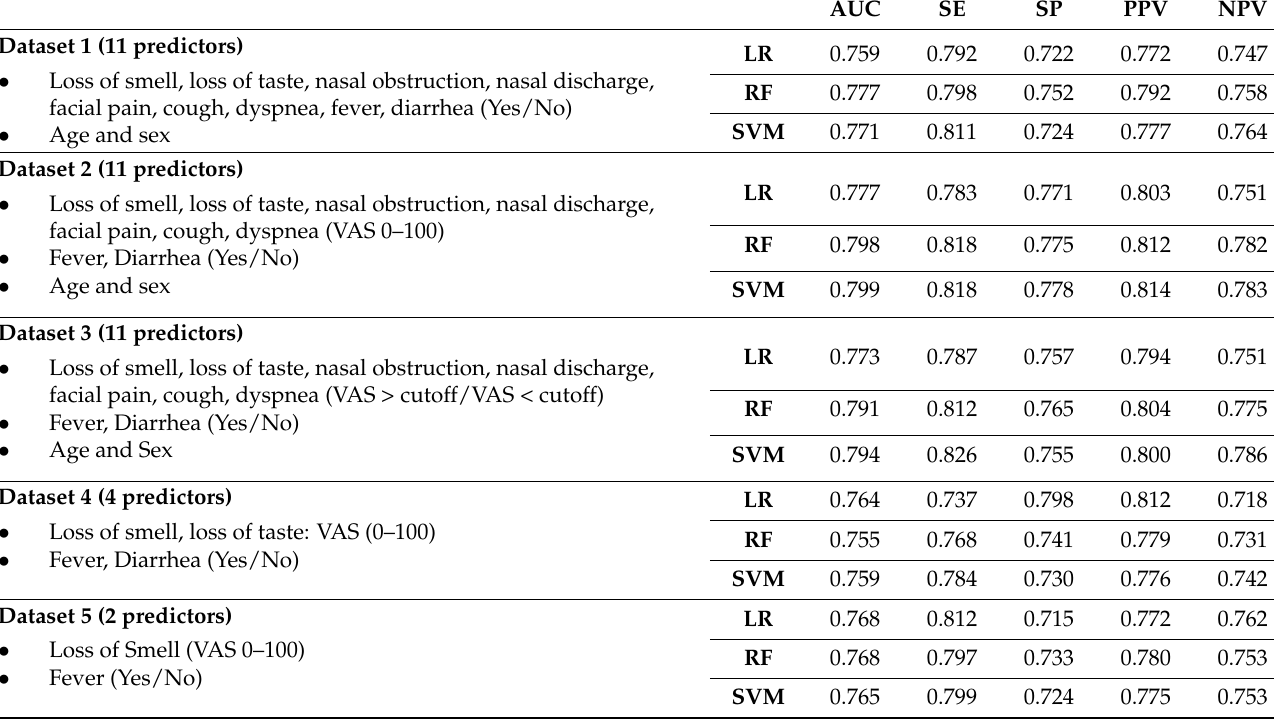
Table 4. Mean AUC, SE, SP, PPV, and NPV values obtained over the 50-fold cross-validation estimates for different datasets (Datasets D1–D5) and three different ML algorithms (LR, RF, and